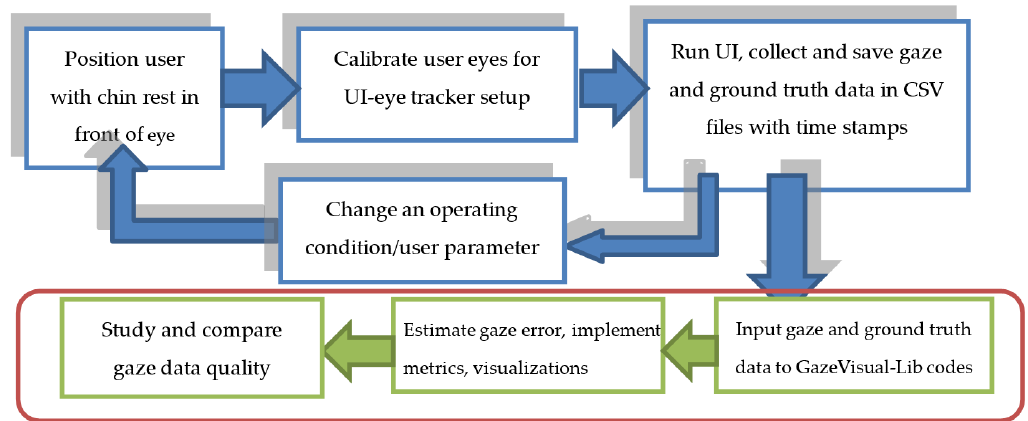
Figure 8. Workflow to implement gaze data evaluation methods of the GazeVisual-Lib repository.